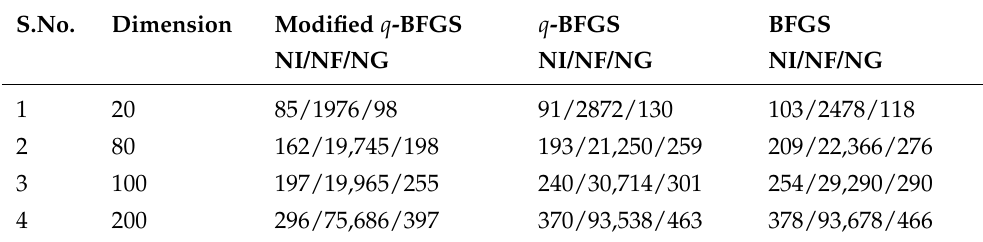
Table 6. Comparison of numerical results of Modified q -BFGS, q -BFGS, and BFGS algorithm for Large Dimensional Wood